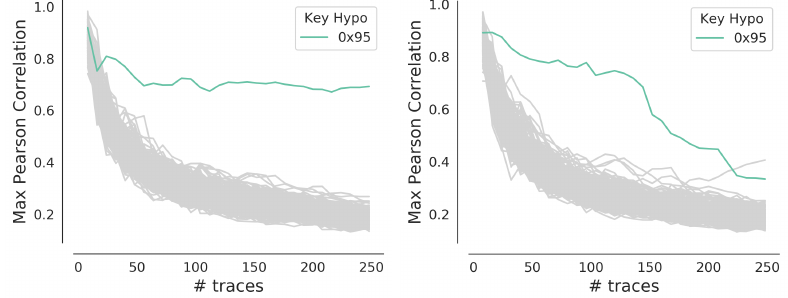
Figure 12: Maximum Correlation coefficients as a function of the number of traces in Step 3 with SNR = 1.0 and N 15 = 0x00 (left) or N 15 = 0x80 (right).